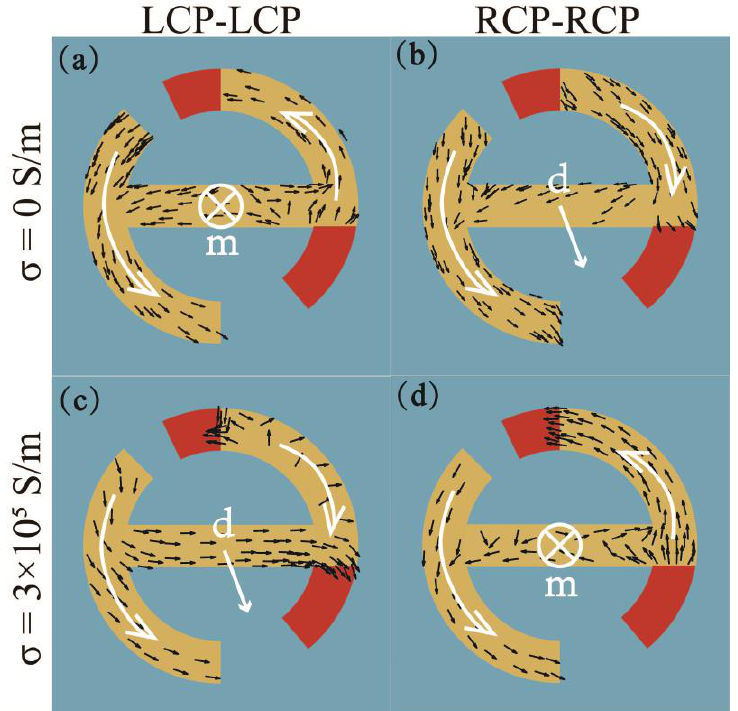
Figure 4. The physical mechanism of the switchable chiral metasurface. The surface current distri- bution of ASRR_1 with conductivities of ( a , b ) 0 S/m and ( c , d ) 3 × 10 5 S/m when LCP and RCP are incident.